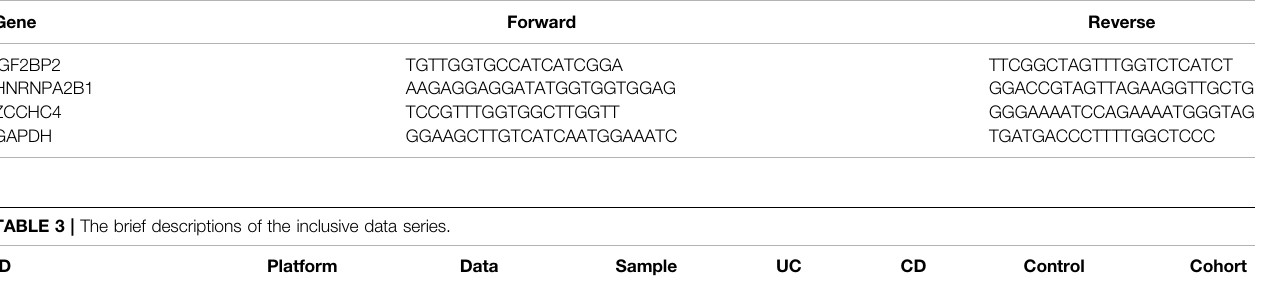
TABLE 2 | The primer sequences.